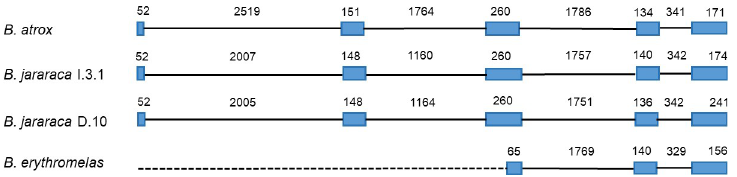
Fig 1. Scheme of SVTLE genes of Bothrops jararaca and B . erythromelas . Numbers inform the sizes of introns (full line) and exons from ATG to stop codon (blue boxes) in nucleotides. The dashed line indicates the deleted region in the B . erythromelas 0903 gene. GenBank accession numbers: B . atrox (X12747.1), B . jararaca I.3.1 (MT547769), B . jararaca D.10 (MT547770), and B . erythromelas 0903 (MT536933).